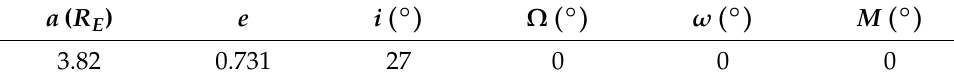
Table 1. Initial orbital elements of spacecraft in J2000.0 for GTO–GEO hybrid